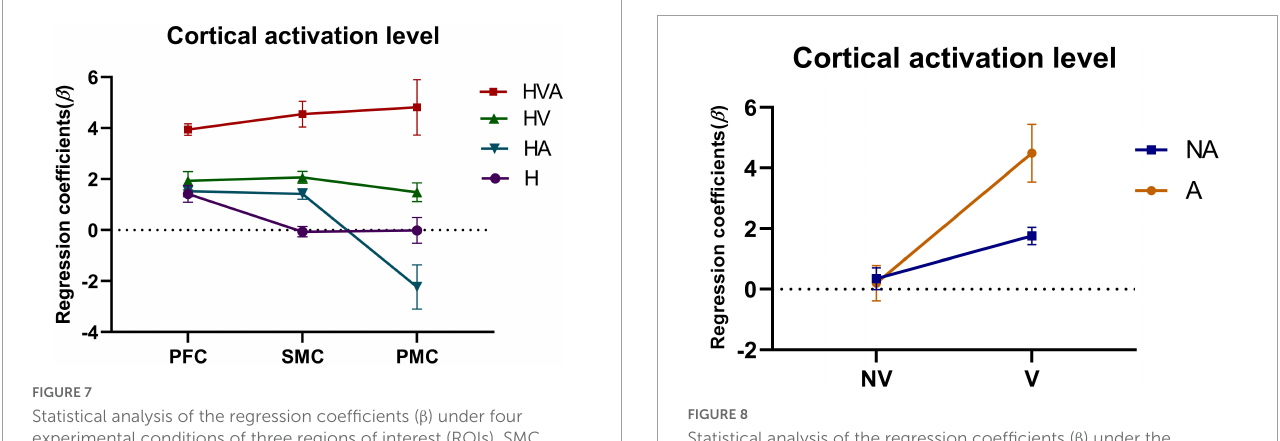
feedback on the activation level. The test statistic of whether there was visual feedback ∗ whether there was auditory feedback was F = 22.168, p < 0.001, indicating that visual and auditory feedback have an interaction effect, which had a significant impact on the activation level. The result of the descriptive statistical analysis was shown in Figure 8 . As can be seen from the figure, in the absence of visual feedback, the impact of auditory feedback on the activation level was similar, while in the presence of visual feedback, the impact of auditory feedback on the activation level was significantly improved.